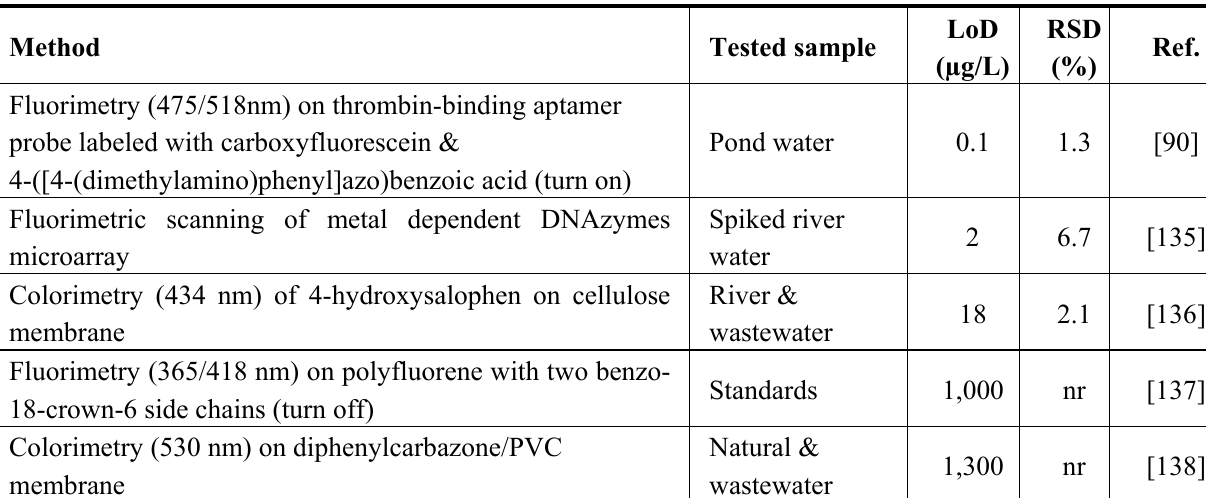
Table 9. Analytical characteristics of optical sensors for lead determination in water published between 2007 and